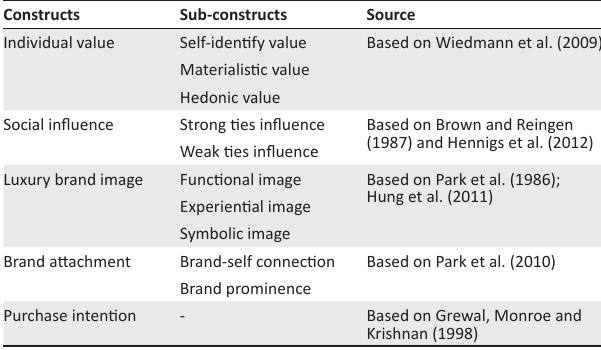
FIGURE 1: Conceptual TABLE 1: Measurement scales.